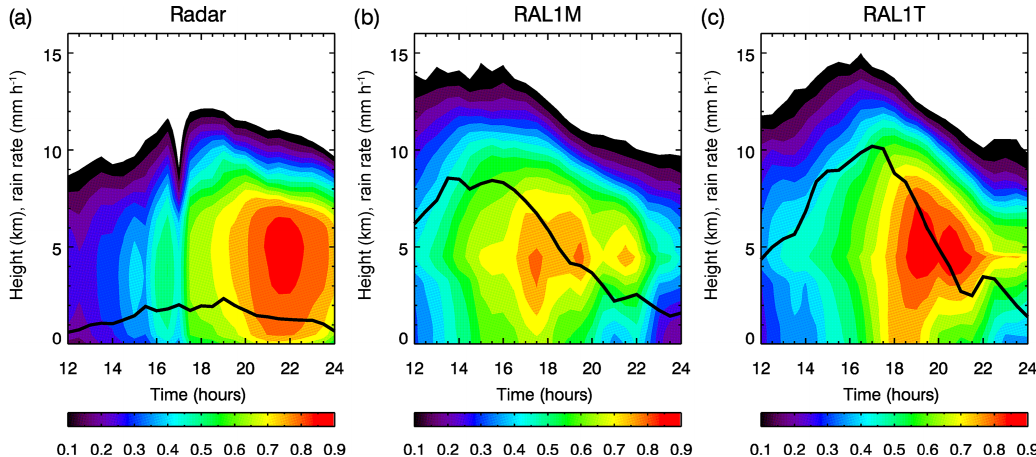
Figure 17. Fraction of radar area covered by reflectivities greater than 10dBZ as a function of height and time (coloured contours) from 12:00 to 24:00UTC on 18 February 2014. Solid lines are the time series of the domain mean rain rate (mmh − 1 ).